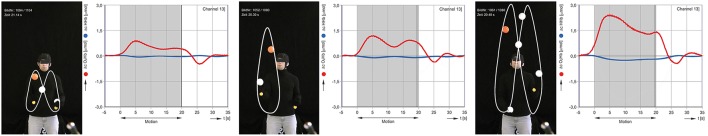
Exemplary results for cinematographic, semi-automated tracking of the balls during juggling. Concentration changes of oxygenated (red) and deoxygenated (blue) hemoglobin in 2-, 3- and 5-ball juggling (average of 8 trials of juggler 2). The gray area marks the onset and duration of the juggling activity.